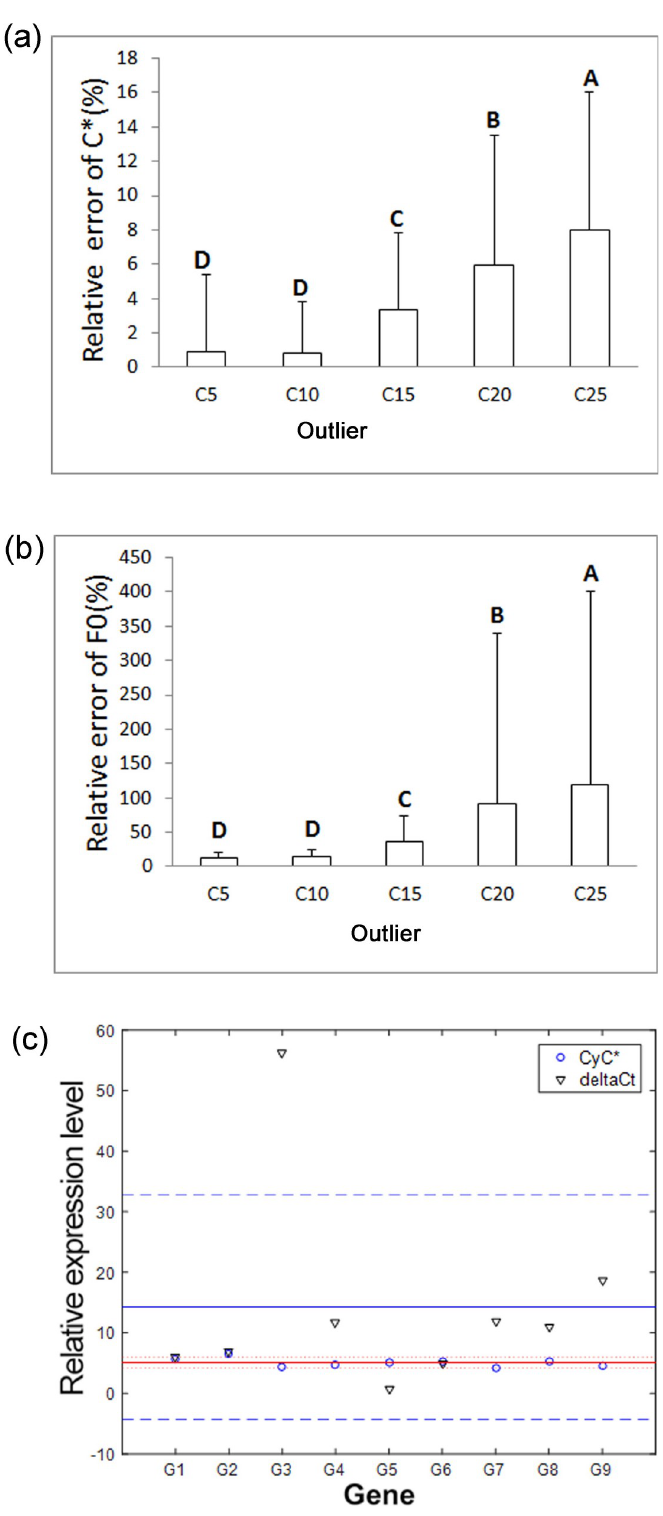
Fig 3. Verification of the CyC � data processing approch using simulations and actual qPCR tests. (a), Relative errors of the outliers ( C � ) for 5 different outliers obtained using C � and estimated C � based on the robust regression analyses in 2000 simulations. Columns with different capital letters differ significantly by one-way analysis of variance